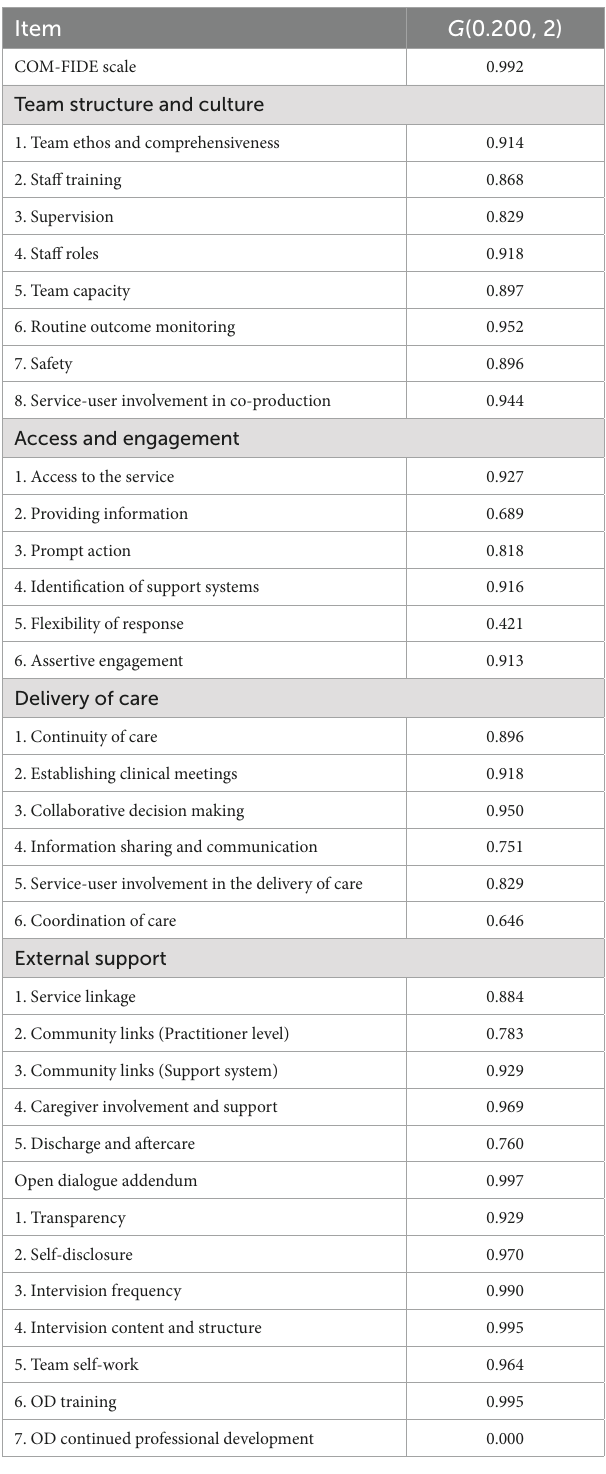
TABLE 2 Inter-rater reliability of the COM-FIDE using the G estimate ( n = 24). Item